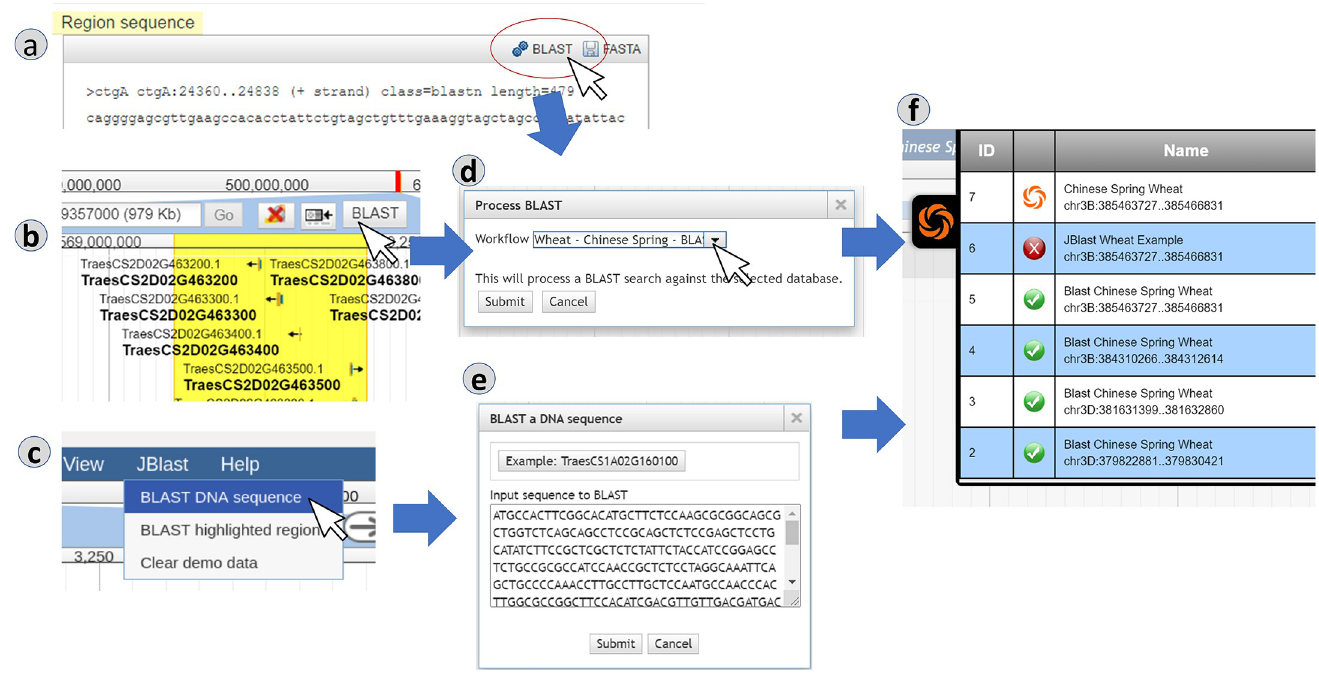
Fig 1. A sequence can be submitted for BLAST search in one of several ways, either with reference-as-query (a region of the genome is selected and then BLASTed against a built-in database) or with reference-as-target (a sequence is uploaded by the user and then searched against the genome). After confirming, the user can track the progress of the search in the built-in job queue. Panels: (a) selection by feature, (b) selection by highlighting, (c) selection by menu, (d) BLAST dialog for reference-as-query, (e) BLAST dialog for reference-as-target, (f) job